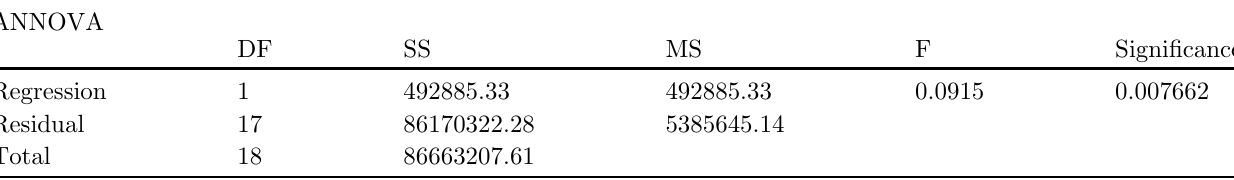
Table 9. Analysis of variance (regression and